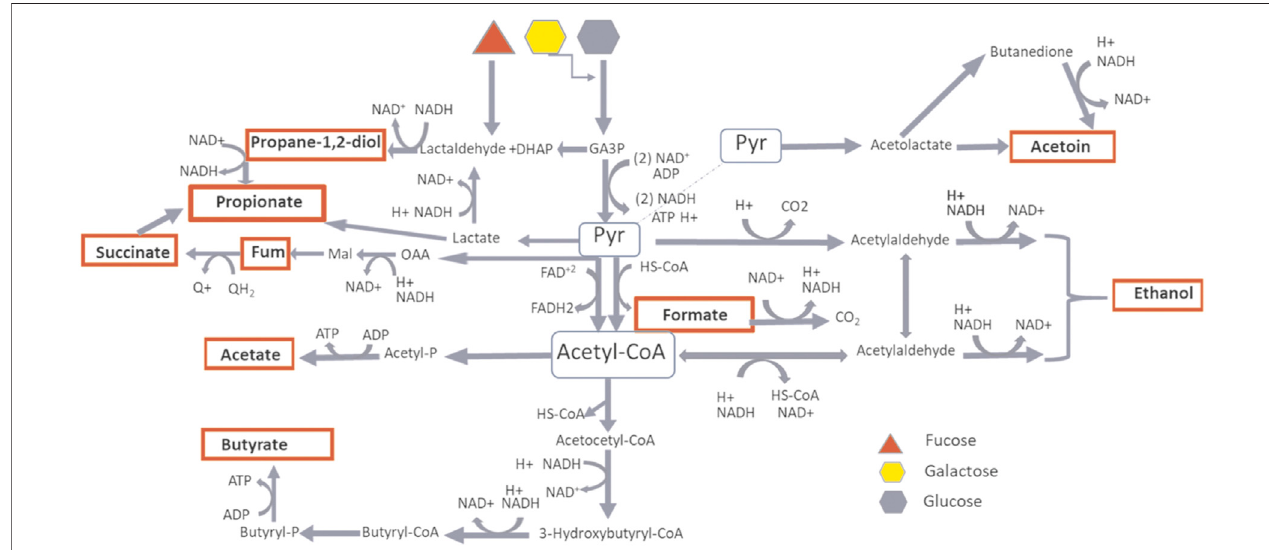
FIGURE 10 | Metabolic pathway of carbohydrate fermentation. In red are highlighted the microbial fermentation ’ s products as measured by NMR spectroscopy. The products depending on Pyruvate hub are predominant during BM and FBM periods, the products depending on AcetylCoA hub are predominant during W